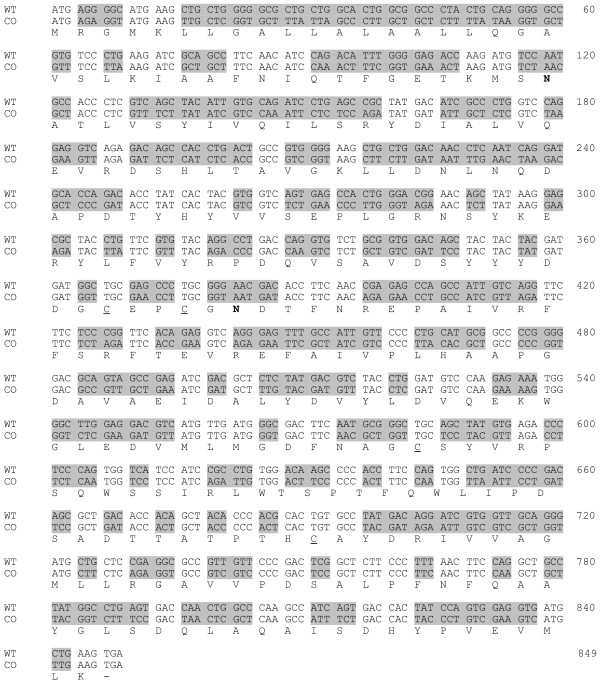
Codon adaptation of the used synthetic DNase I gene. As the codon bias of T. thermophila is different from that of human genes 67% of 283 coding triplets of the original human codons (WT) were changed into codons that are known to be mostly present in highly expressed T. thermophila genes (CO) [13,16]. The adapted codons are marked by gray boxes. The corresponding amino acid sequence is given in single letter code; N-glycosylation sites are highlighted in bold letters, cysteines forming disulfide bridges are underlined.